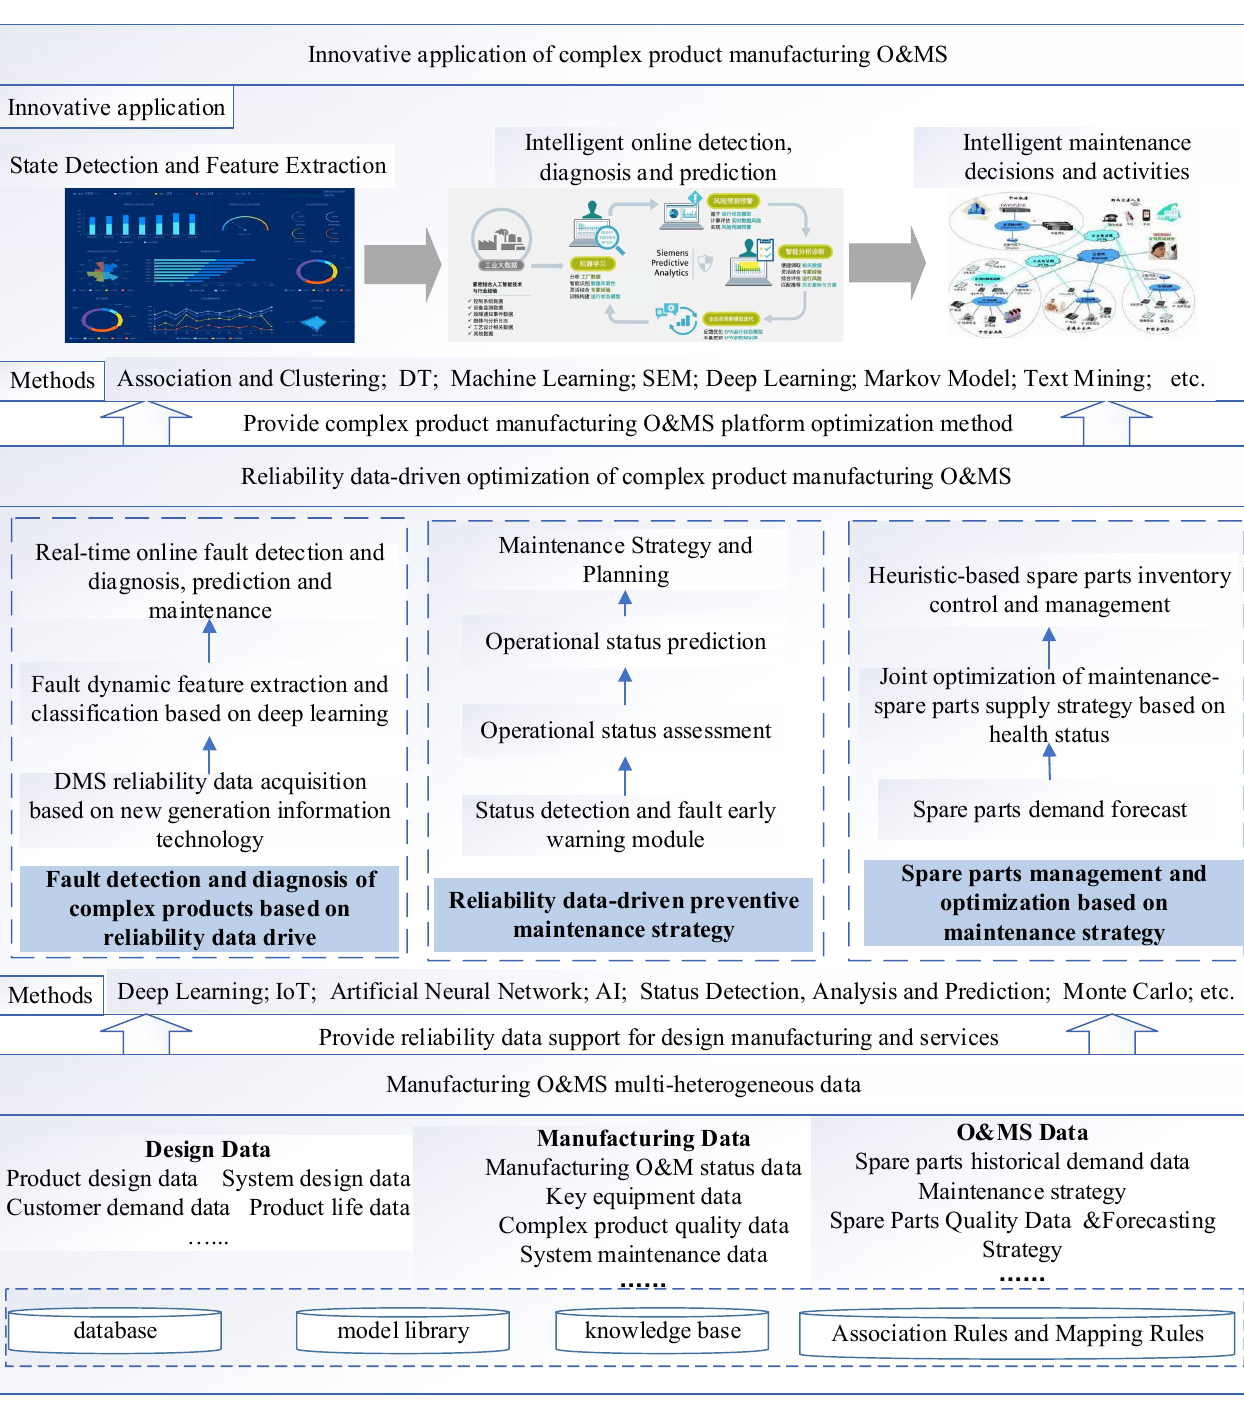
Figure 4. Framework for complex product O&MS optimization driven by multi-source heterogeneous reliability data.